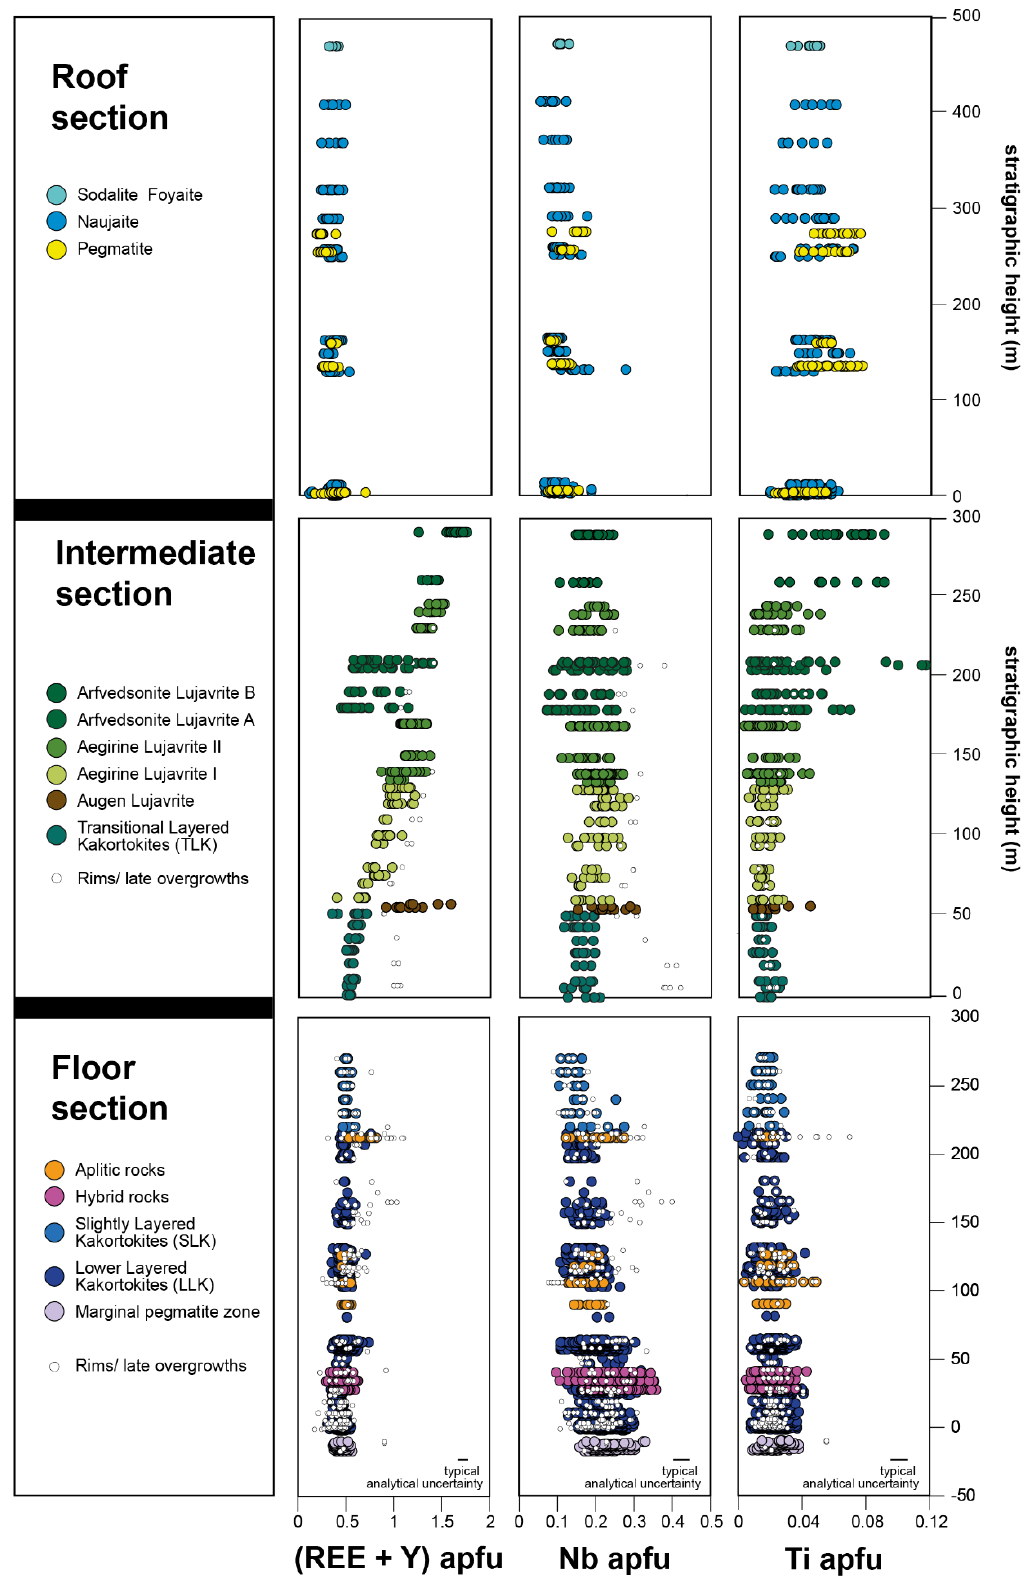
Figure 5. Compositional variation of eudialyte-group minerals (EGM) across the three major stratigraphic sections of the Ilímaussaq Complex, south Greenland expressed as (REE + Y) apfu, Nb apfu and Ti apfu.